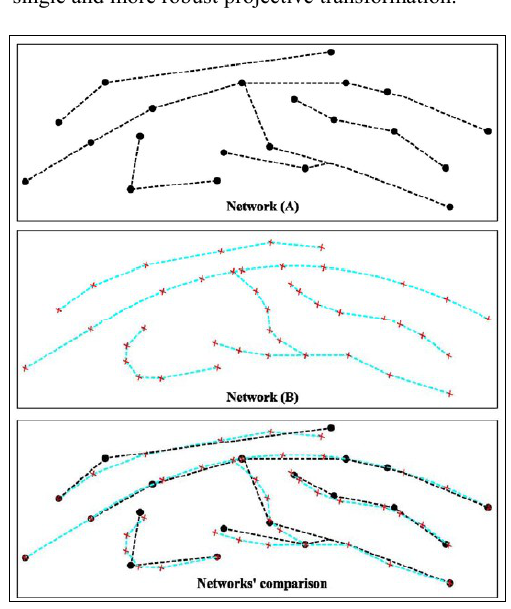
Figure 1. Networks of heterogeneous